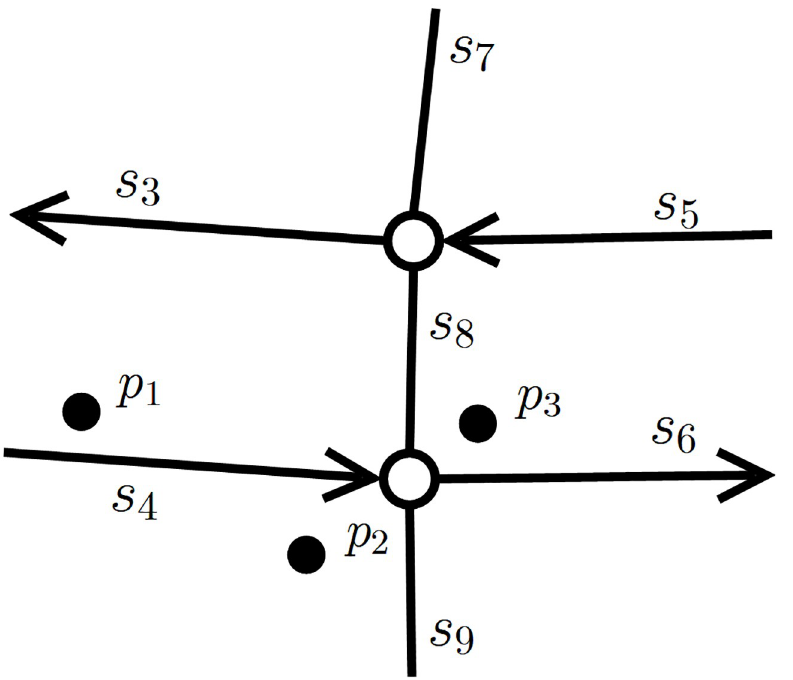
Fig 4. Current vehicle positions and the nearby road